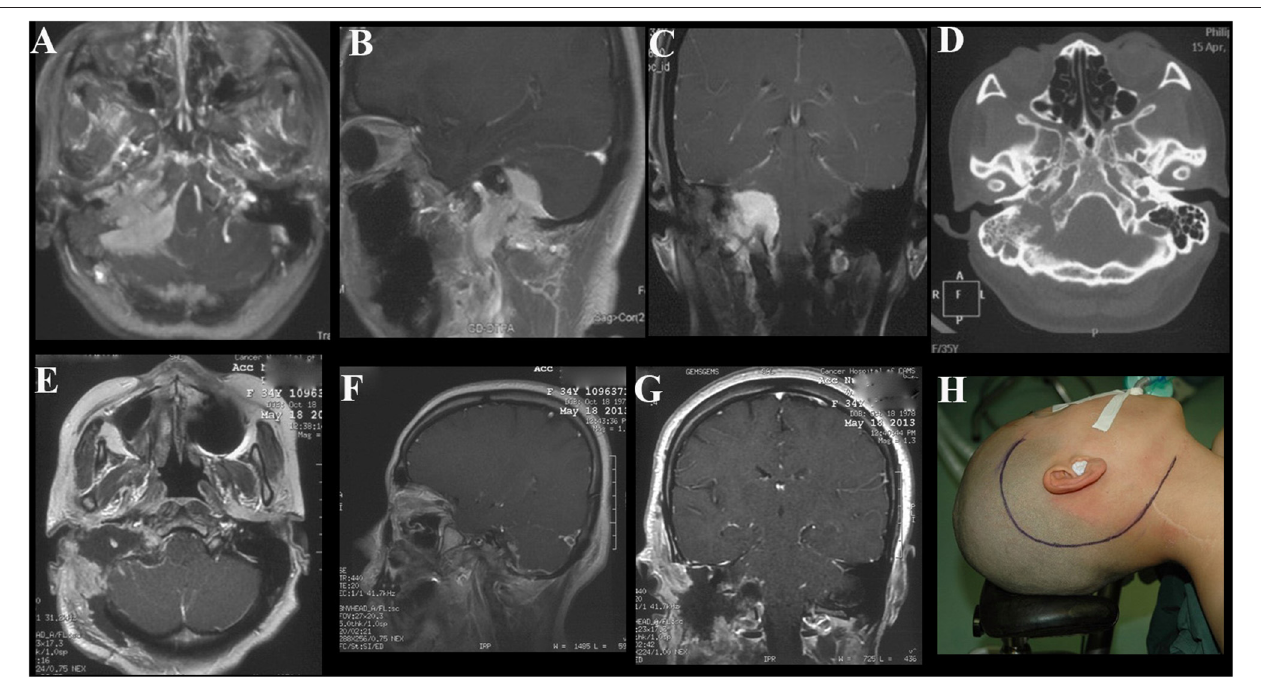
FIGURE 5 | Case illustrating the combined craniocervical approach. (A–C) T1-weighted contrast-enhanced MRIs demonstrate a tumor with homogeneous enhancement located in the right jugular foramen with both posterior cranial fossa and neck extensions, dural tail signs are found in the posterior fossa. (D) CT scan with the bone-window algorithm shows the enlarged jugular foramen with bone destructive change. (E–G) Postoperative contrast-enhanced MRIs indicate satisfactory tumor resection. (H) The incision of the combined craniocervical approach.